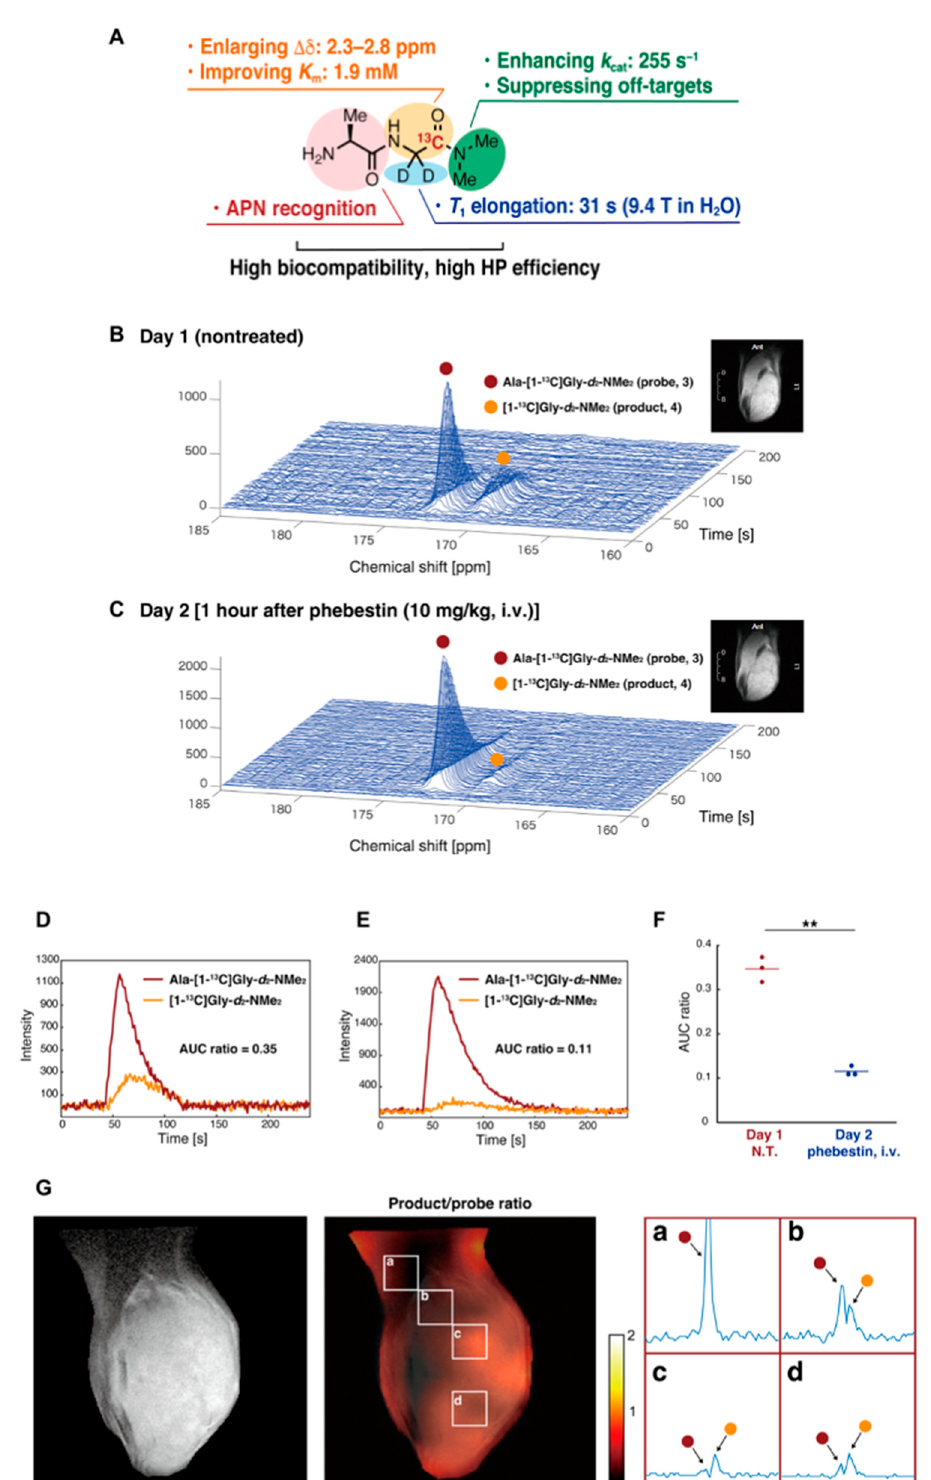
Figure 12. Development of a molecular probe to detect APN activity by precise molecular design. ( A ), Physicochemical and biological characteristics of the Ala-Gly-d 2 -N-Me 2 . ( B ), Detection of the APN activity in mice-bearing MiaPaCa-2 tumor xenografts. Nontreated ( B ) treated ( C ) with the APN inhibitor (1 h after the phebestion administration) in the next day. ( D – F ), The profile of APN probe and the metabolites nontreated ( D ) or treated ( E ) with phebestin. The data are quantitatively shown as AUC ratios. ( G ), Co-registration of T2-weighted anatomical image and 13 C CSI image of the APN probe. The part of the matrix (a–d) is expanded. **: n = 3 and P = 0.009.